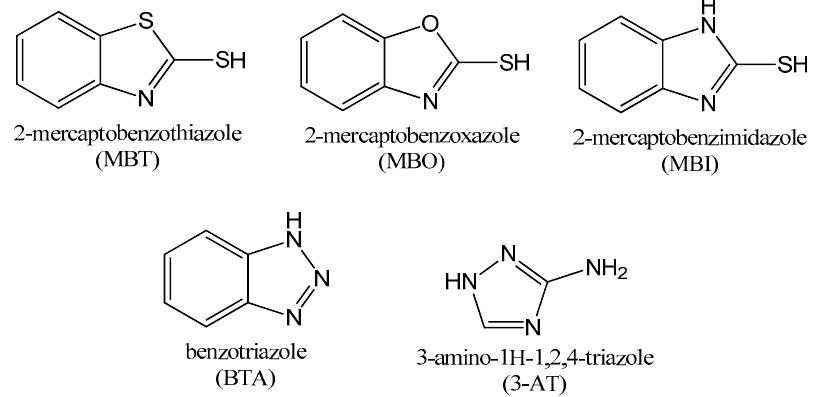
Figure 1. Structures of the five azole compounds used in this study.